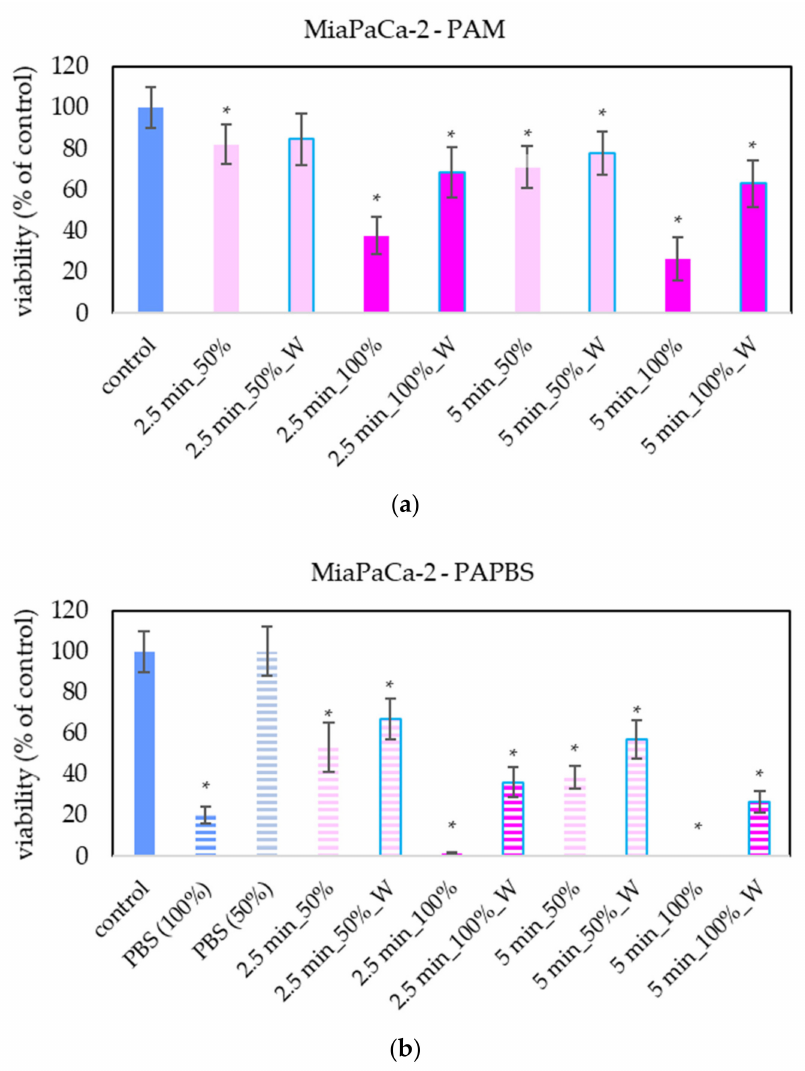
Figure 5. Effect of PAL on cell viability of pancreatic cancer cells 24 h after PAL application. Plasma- activated medium (PAM) ( a ) or plasma-activated PBS (PAPBS) ( b ) activated for 2.5 or 5 min in 100% or 50% concentration were used. Time of PAL action was 24 h (without blue frames) or 30 min, after which PAL were replaced with untreated medium (“washing”, W, blue frames). The significant results ( p < 0.05) are marked with *. Significance of 100% PAPBS, resp. 50% PAPBS was tested compared to in 100% PBS, resp. 50% PBS, significance of other samples compared to control. Viability was normalized to the control cells incubated in the